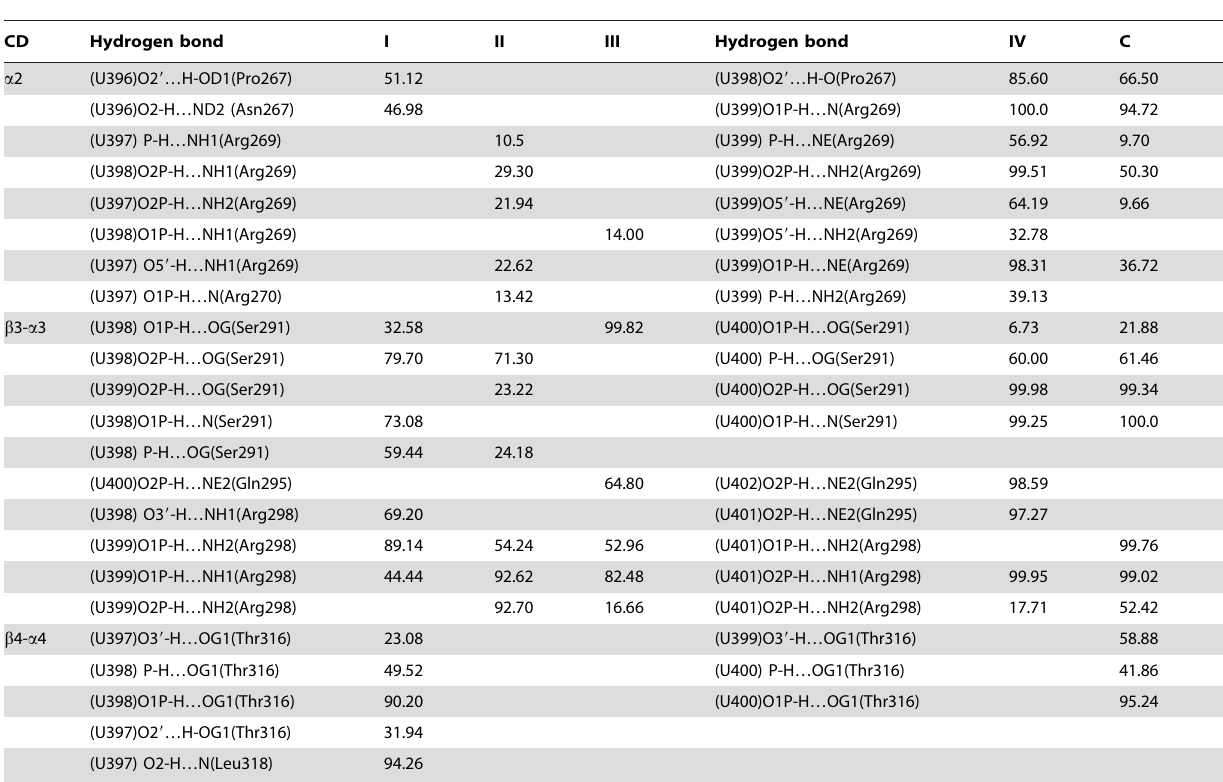
Table 4. The occupancies (%) of hydrogen bonds between the RNA molecule and the C-domain (CD) of the eIF4A protein for the I, II, III, IV and ATP + RNA + C-eIF4A (C) models.